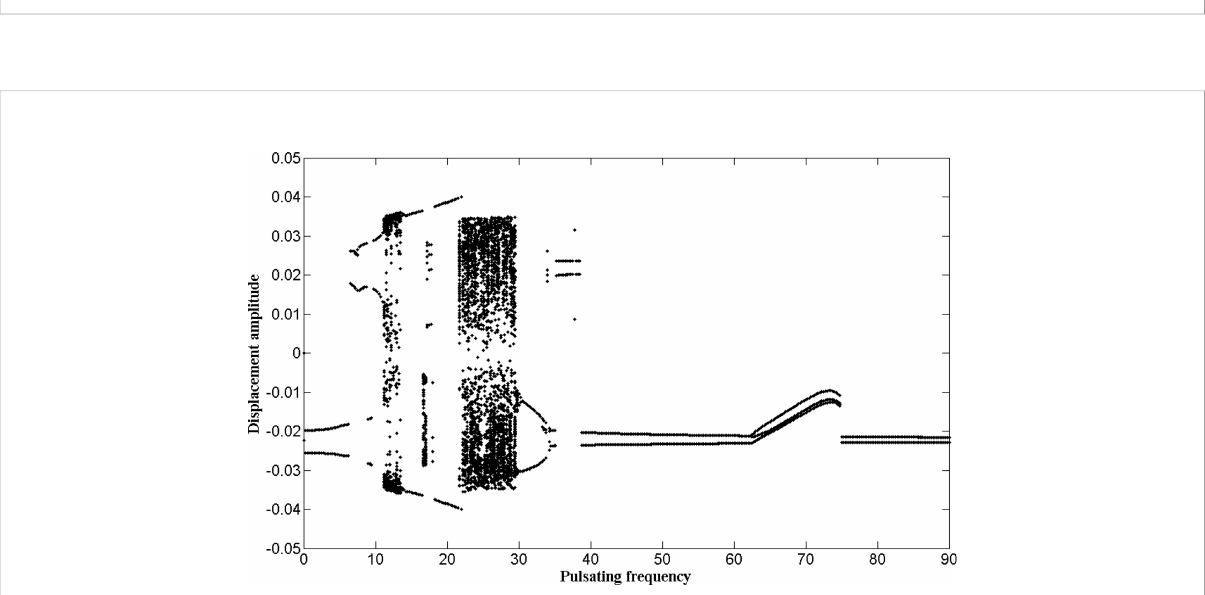
FIGURE 18 The bifurcation diagram for the midpoint of the pipe when the moving speed is higher than the divergent critical velocity (in which m = 0.6, u = 2, υ = 4.5, and the control parameter is the pulsating frequency w p